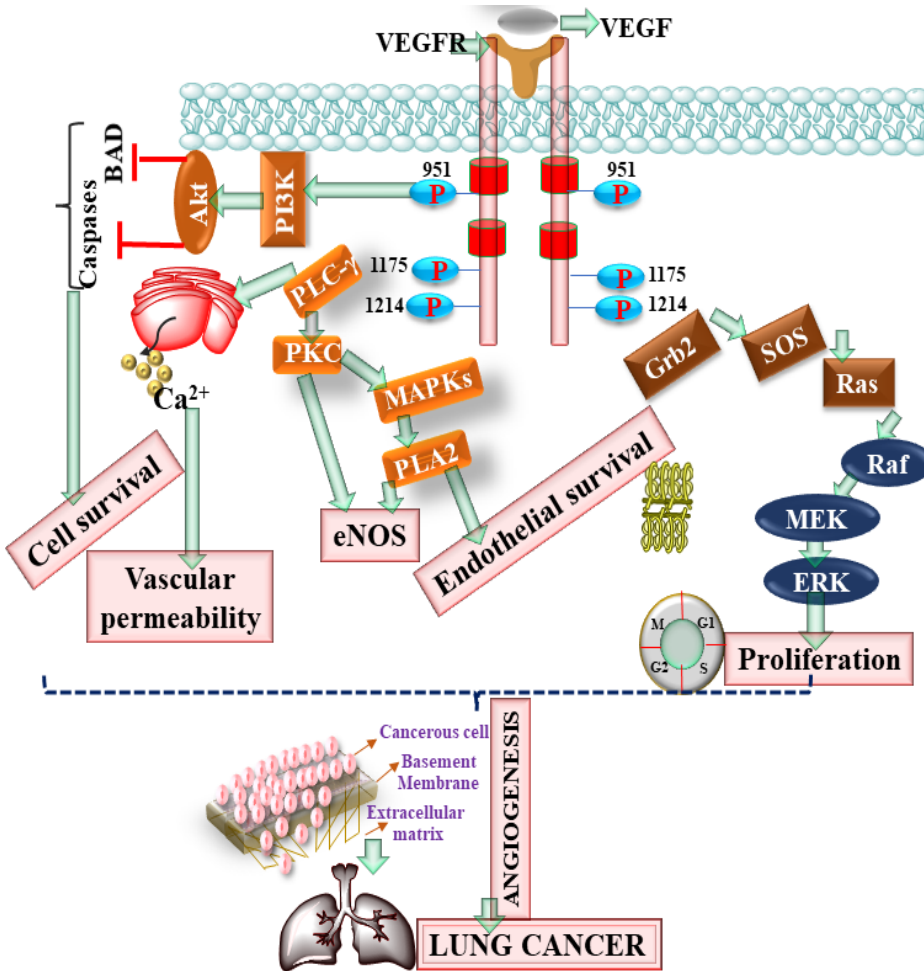
Figure 2. Showing the role of the vascular endothelial growth factor receptor (VEGFR) pathway in lung cancer. Protein kinase B (Akt), phosphoinositide 3-kinases (PI3K), (PLC), phospholipase C (PLC), protein kinase C (PKC), Phospholipase A2 (PLA2), extracellular-signal-regulated kinase (ERK), and endothelial nitric oxide synthase (eNOS).